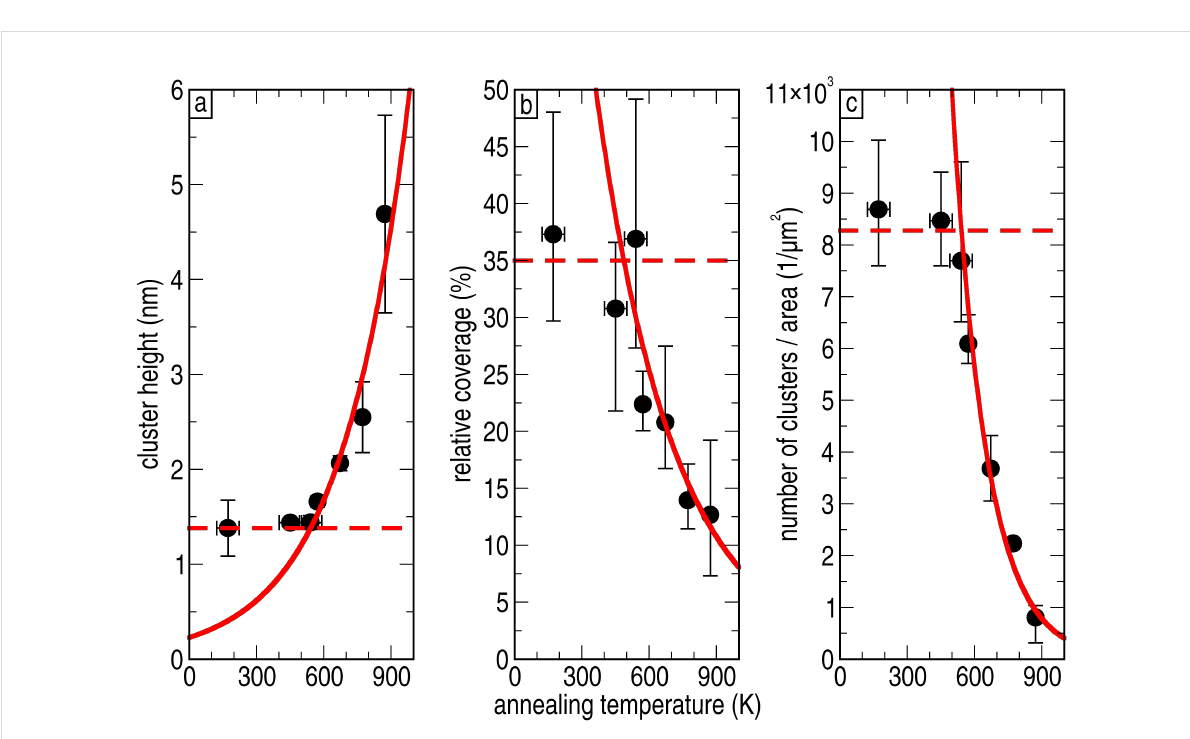
Figure 5: Temperature dependence of the annealing behaviour for (a) the height of the clusters, (b) the percentage of surface covered by the clus- ters, and (c) the number of clusters per area (cluster density n ). The annealing process can be divided into two parts: First, for mild annealing ( T ≤ 500 K) where no diffusion takes place (indicated by the red dashed line), and second, for higher annealing temperatures with an exponential increase in height, and an exponential decay in coverage and number of clusters per area (solid red